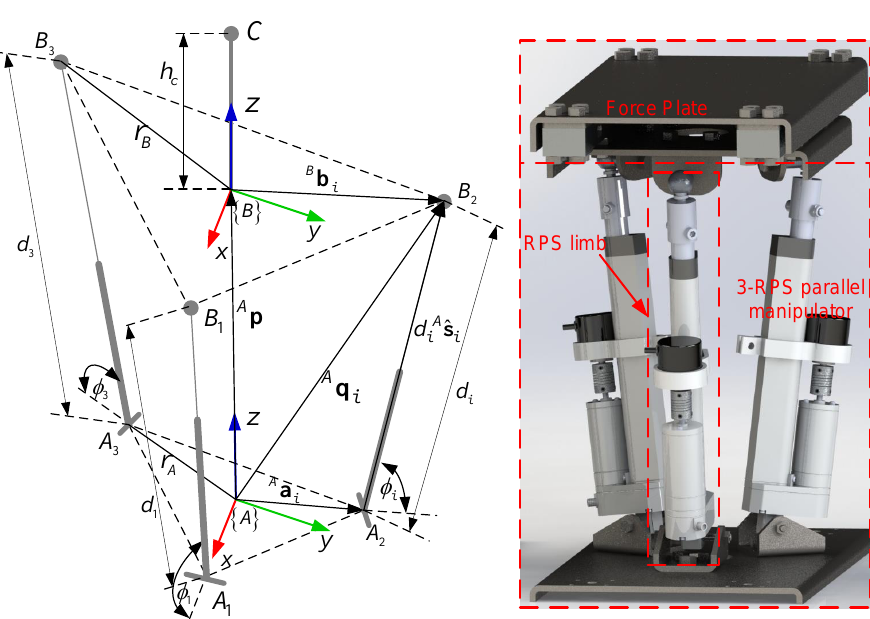
Figure 6. Geometry of 3-RPS parallel